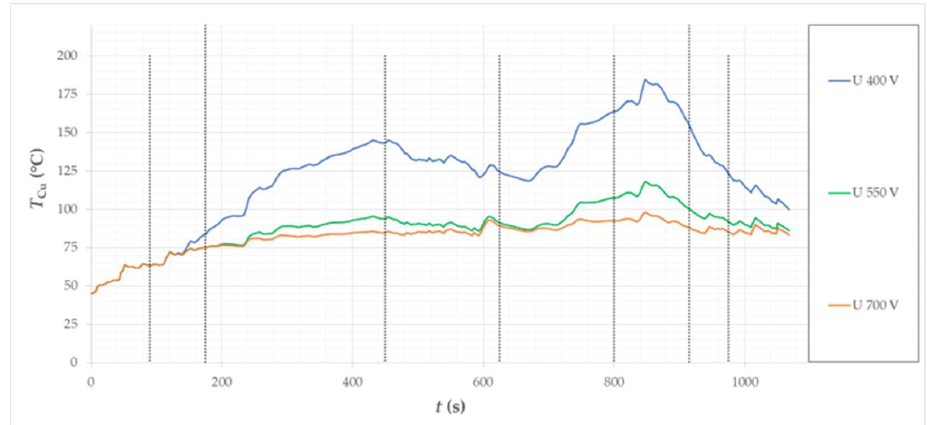
Figure 36. Calculated temperature waveforms in the motor winding (hot spot) for the considered vehicle in the Artemis Motorway150 driving cycle.